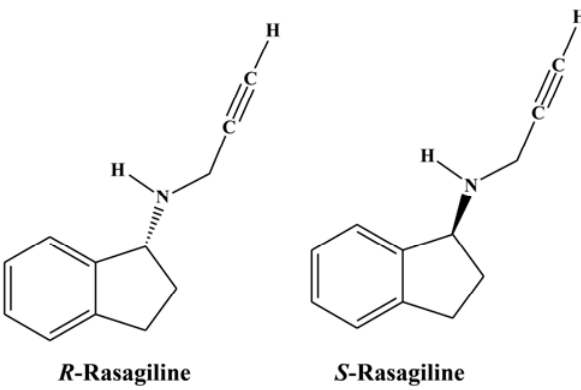
Figure 1. Chemical structures of R ‐ rasagiline (RAS) and S ‐ rasagiline (RAS ‐ III).